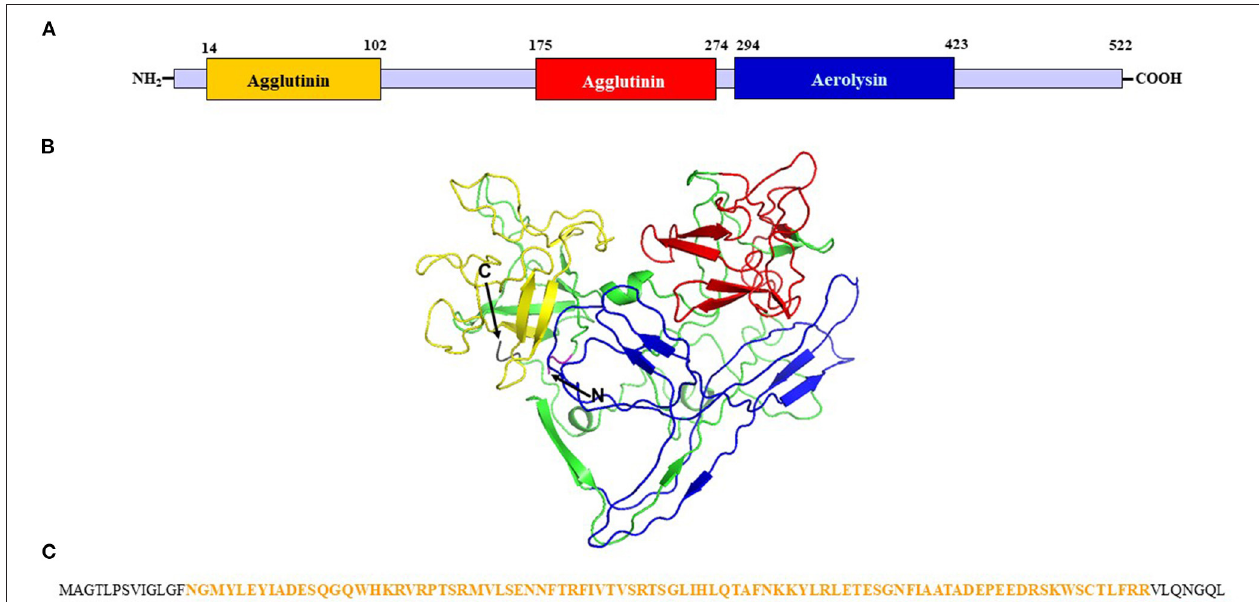
FIGURE 1 | Structural characterization of the AhN4L-1 protein. (A) Diagram showing the length of the AhN4L-1 protein and the localization of the two agglutinin-like domains and the sole aerolysin domain. (B) The molecular modeling of AhN4L-1 shows both agglutinin monomers at the N-terminal end of the protein, colored yellow and red, respectively, connected to an aerolysin-like domain, colored blue. The model was generated using the tools described in https://zhanglab.ccmb.med.umich. edu/I-TASSER. (C) The 522-long amino acid sequence of the AhN4L-1 protein. The segments corresponding to the agglutinin-like and aerolysin-like domains are colored in yellow, red and blue,